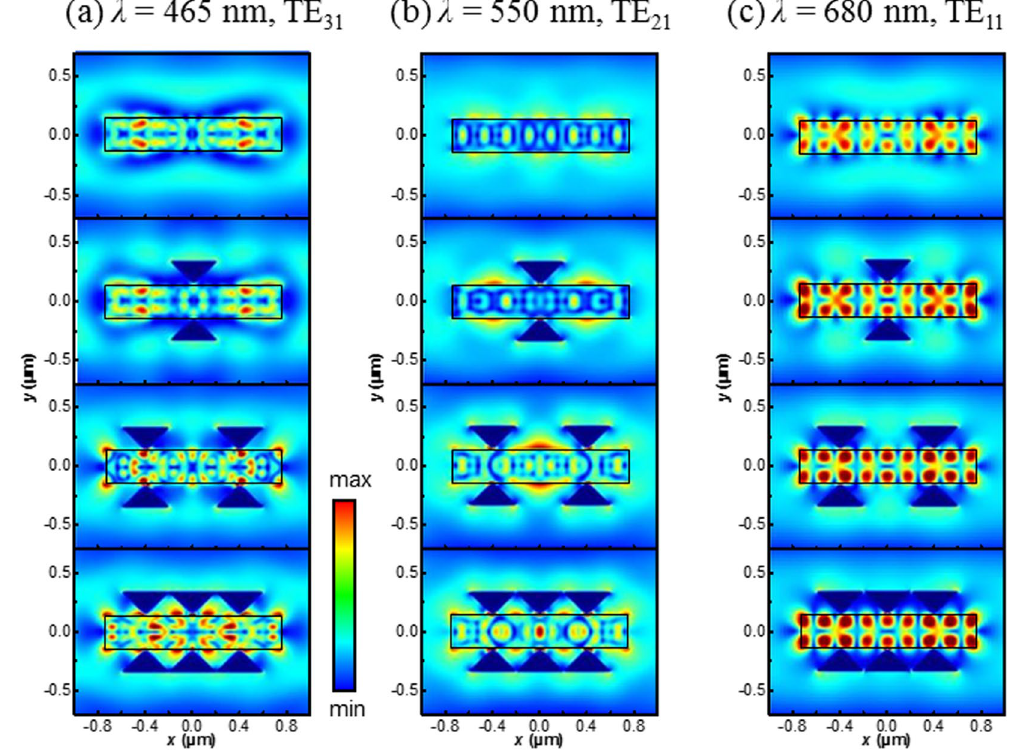
Figure 6. Calculated electric near-field distribution of the NW-antenna system with TE polarized light across the NW plotted in the horizontal plane of the device. ( a )–( c ) Show the electric field intensity for the wavelength of 465 nm (TE 31 ), 550 nm (TE 21 ) and 680 nm (TE 11 ) for NW with and without the bowtie antennas,